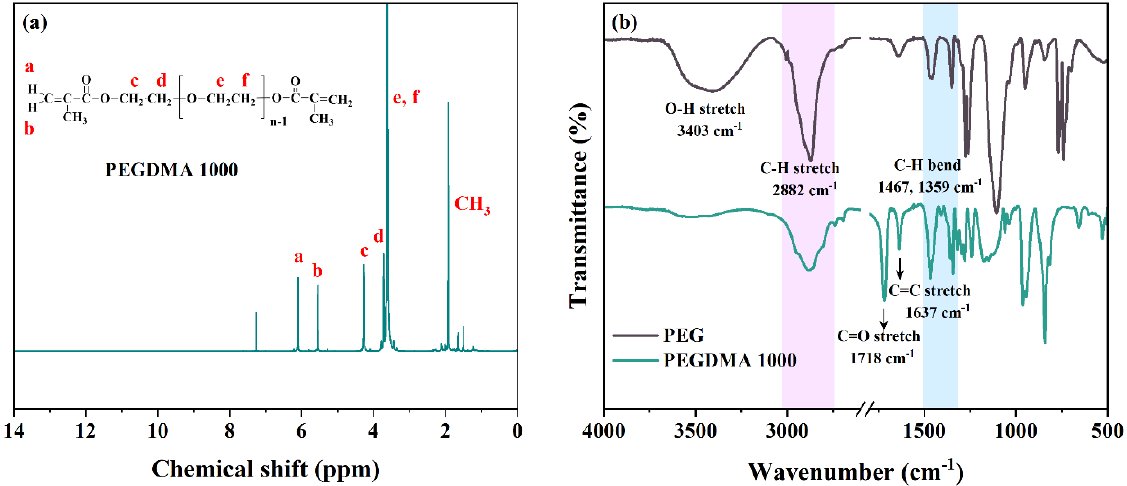
Figure 1. ( a ) 1 H-NMR spectra of PEGDMA 1000, ( b ) FT-IR spectra of PEGDMA